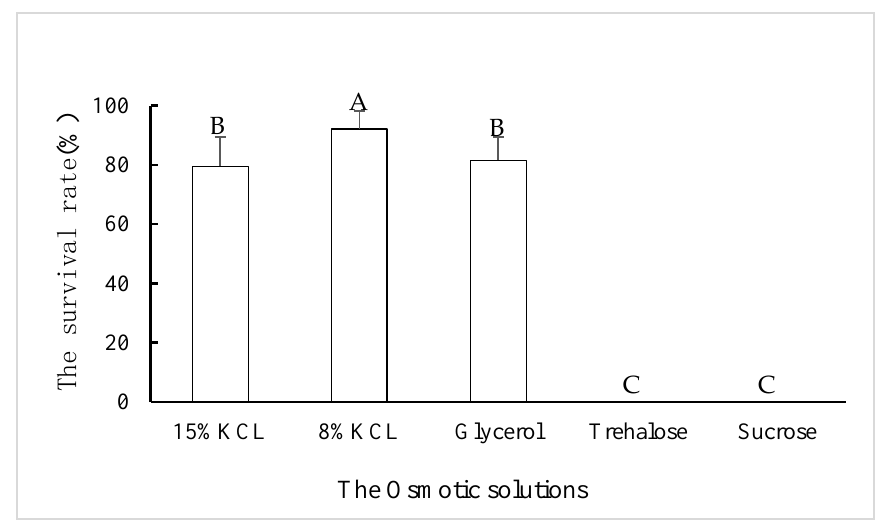
Figure 2. The survival rates of Bursaphelenchus xylophilus third-stage dispersal juveniles after cryptobiosis by dehydration under −20 °C. Note: Different letters indicate significant differences in survival for different osmotic solutions.